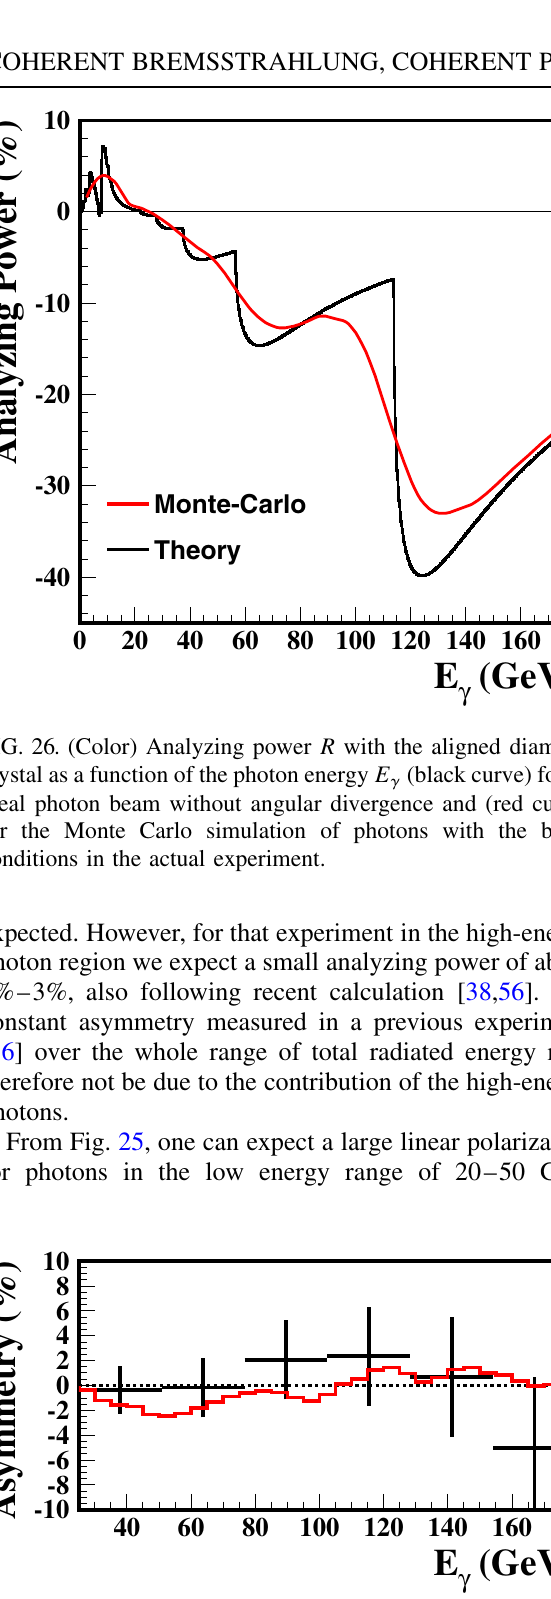
FIG. 27. (Color) Asymmetry of the e (cid:9) e (cid:1) pair production in the aligned diamond crystal as a function of the photon energy E (cid:1) which is measured to determine the P component of the photon 1 polarization in the SOS-aligned Si crystal by 178 GeVelectrons. The black crosses are the measurements and the red histogram represents the Monte Carlo